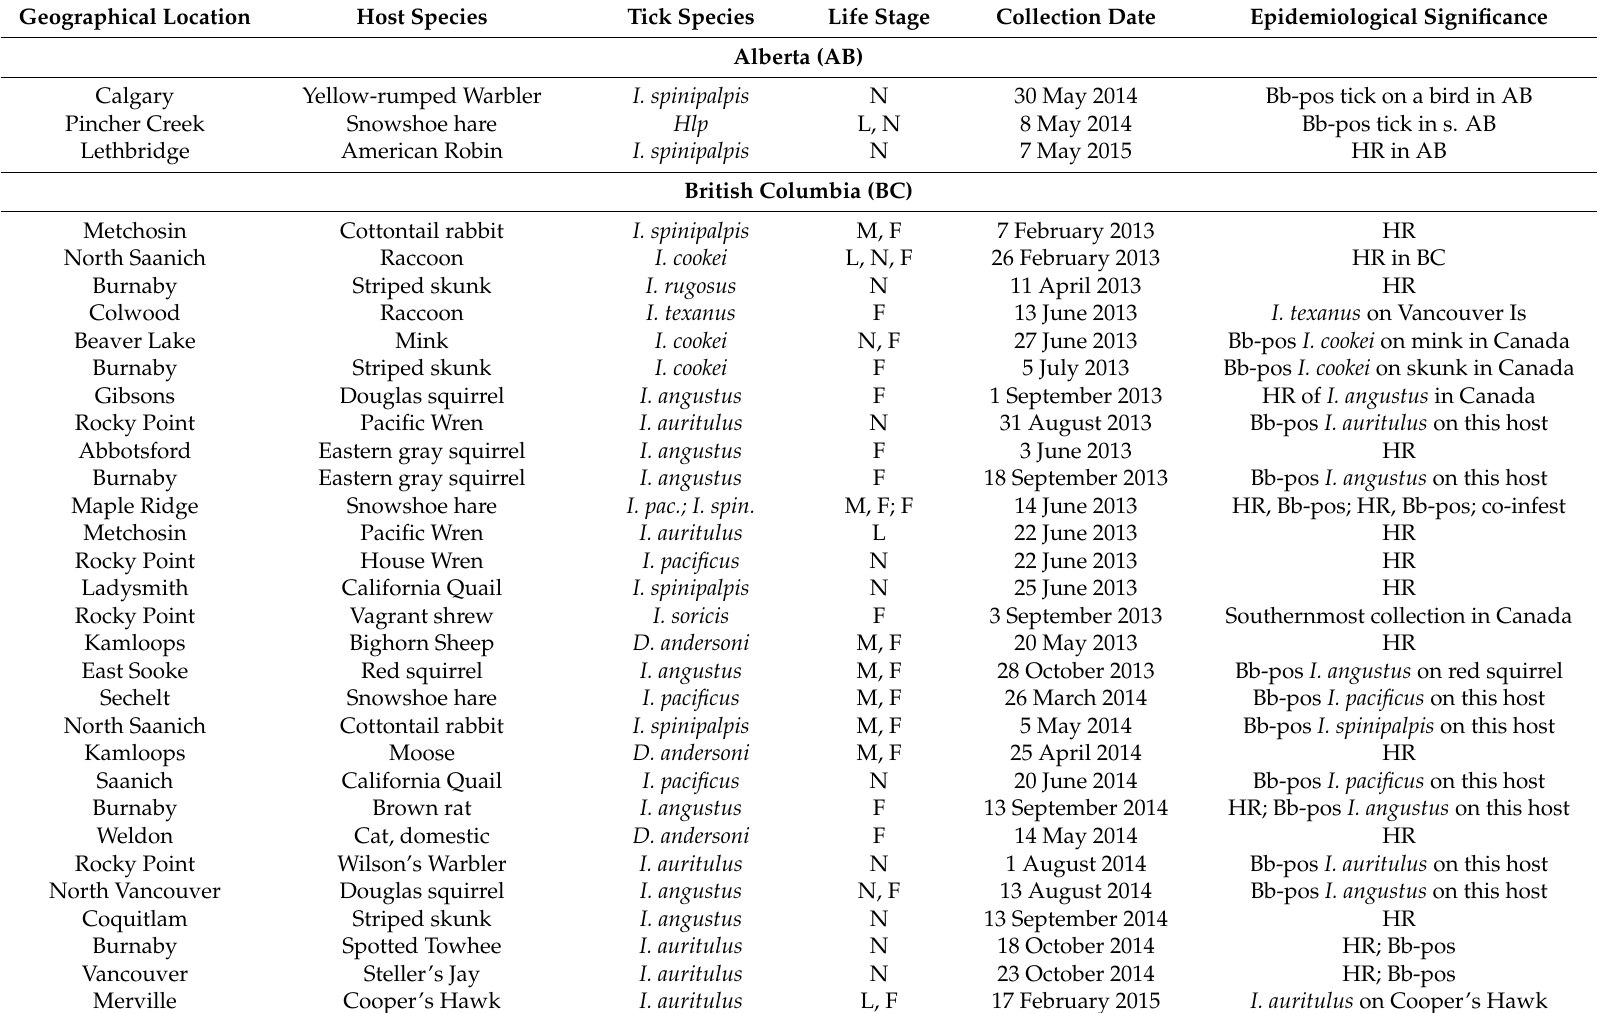
Table 6. Tick–host records for birds and mammals in Canada, and B. burgdorferi sensu lato in ticks, by province,